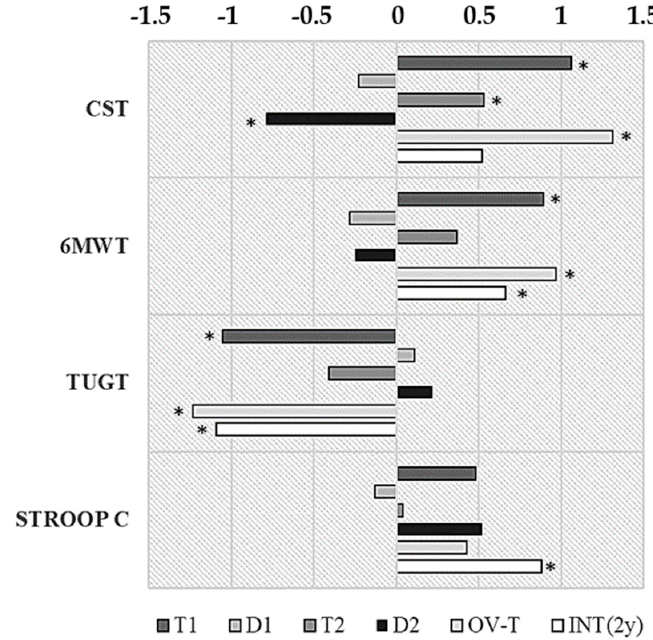
Figure 4. Effect size for the training and detraining changes along two years in EFAM-UV©.